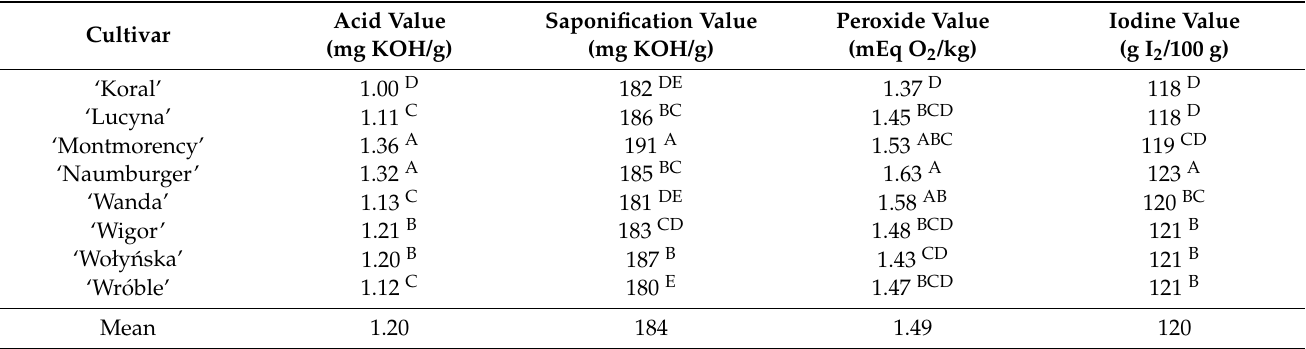
Table 2. Quality parameters of oils from kernel of eight sour cherry